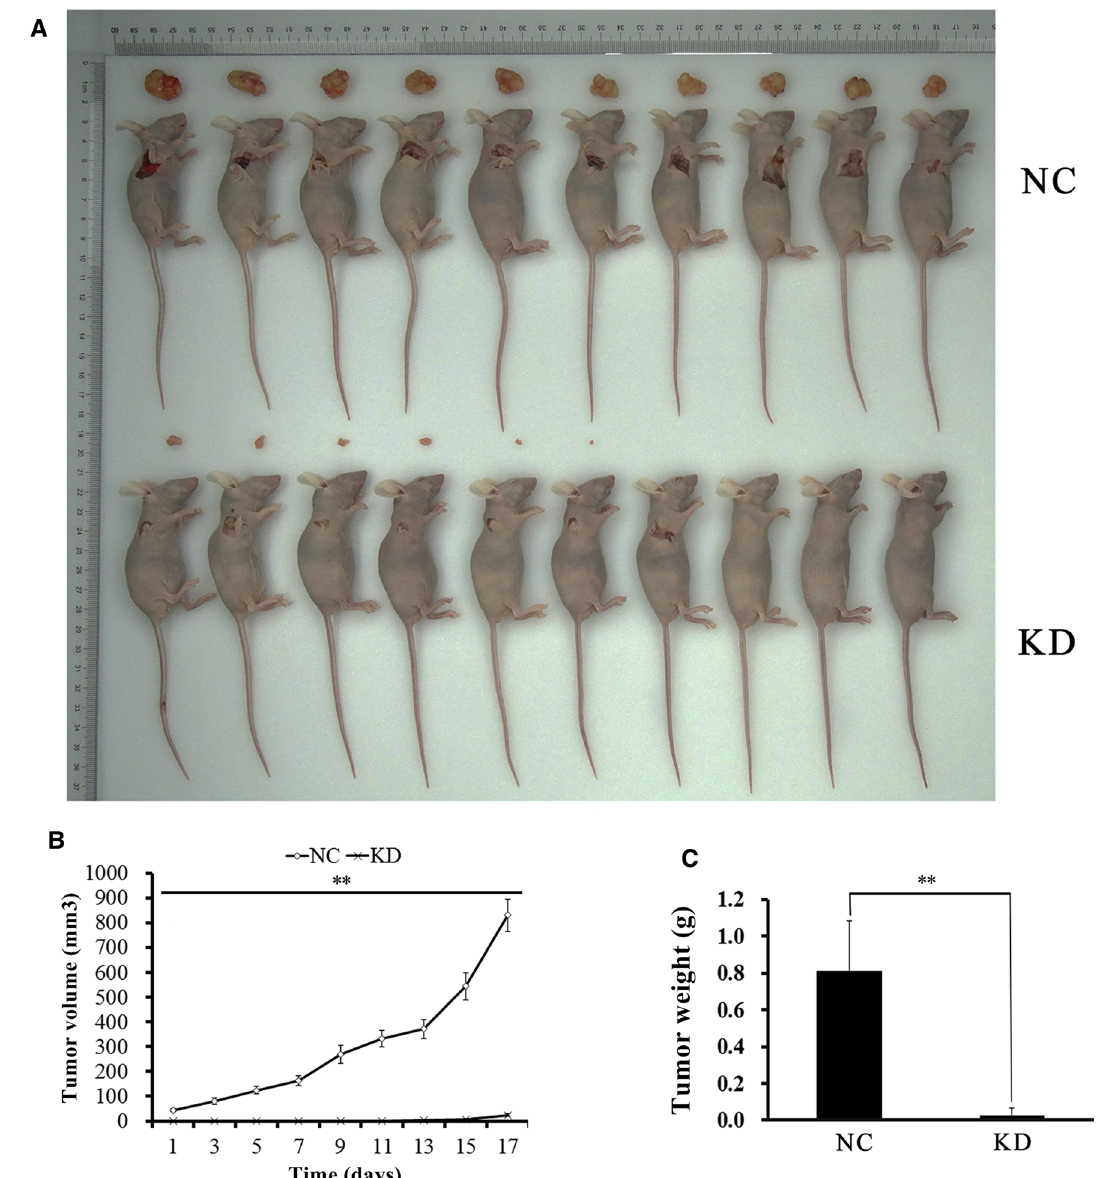
ured 28 days after s.c. injection. NC negative control tumor group, KD PAIP1-knockdown tumor group. * P < 0.05, ** P < 0.01 means significant difference between NC and KD group from the beginning